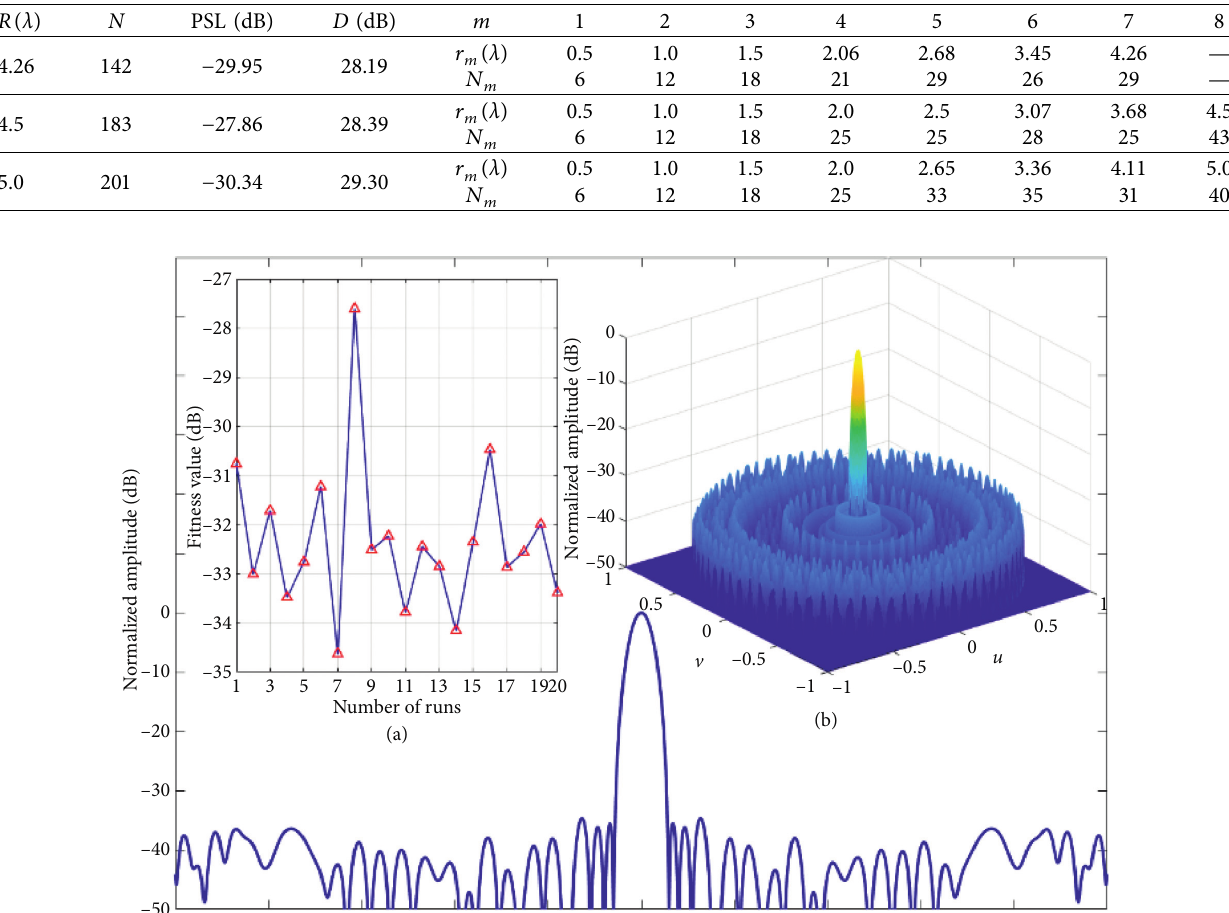
Figure 2: 3D pattern of the UECRA when N � 183. Table 1: Synthesis results obtained by PDT-DE for the cases N � 142, 183, and 201.